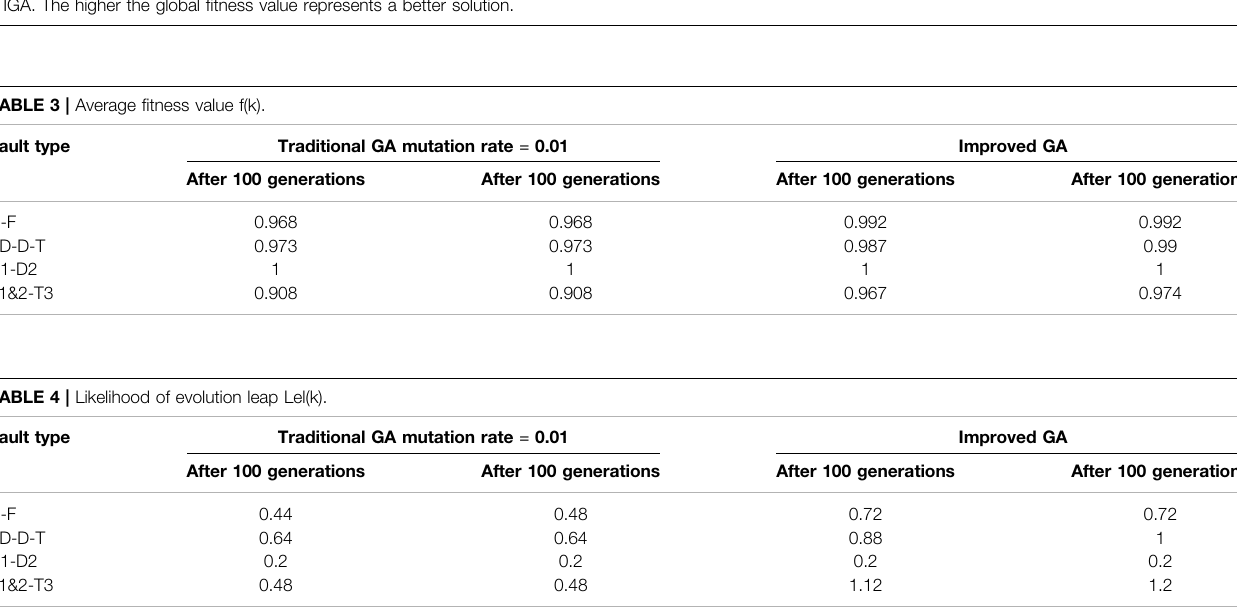
FIGURE6| Thecomparisonoftheglobalbest fi tnessvalueamongmethods, (A) istheglobalbest fi tnessvalueoftheTGA, (B) istheglobalbest fi tnessvalueofthe IGA. The higher the global fi tness value represents a better solution.